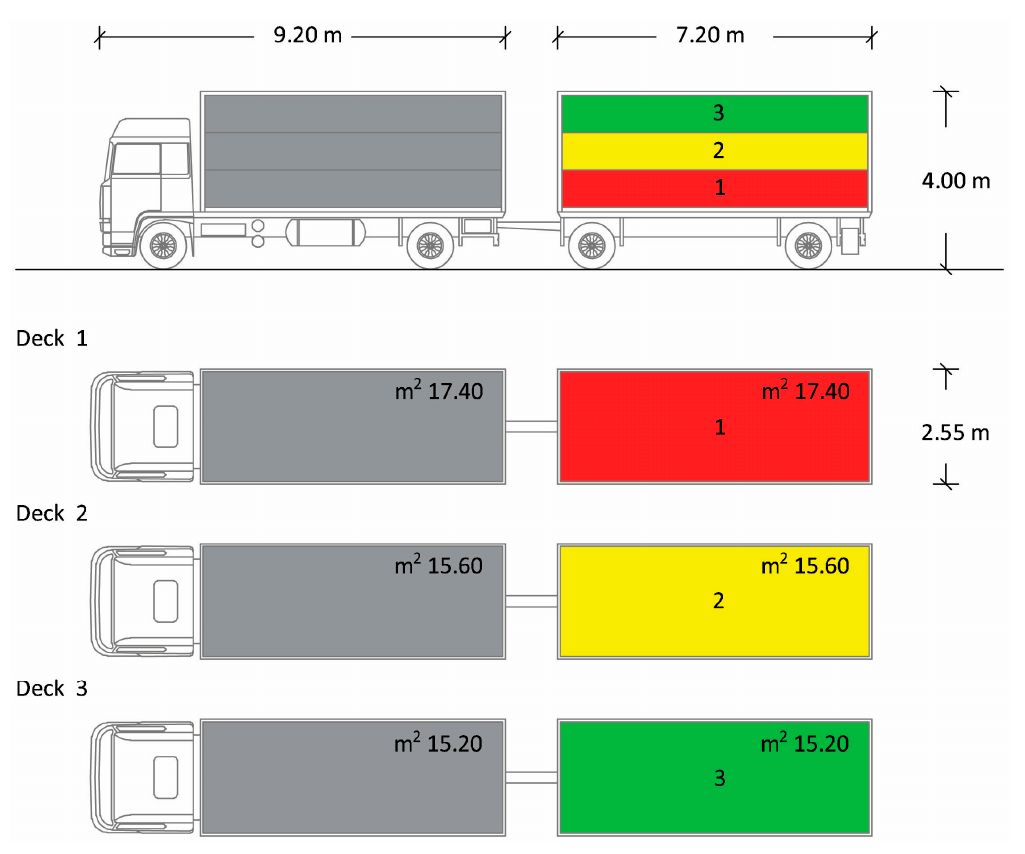
Figure 1. Schematic drawing of the truck used for pig transportation. The truck was composed of a lorry and a trailer and sectioned into 3 compartments: decks 1, 2 and 3. Only the animals travelling in the trailer were included in the study.